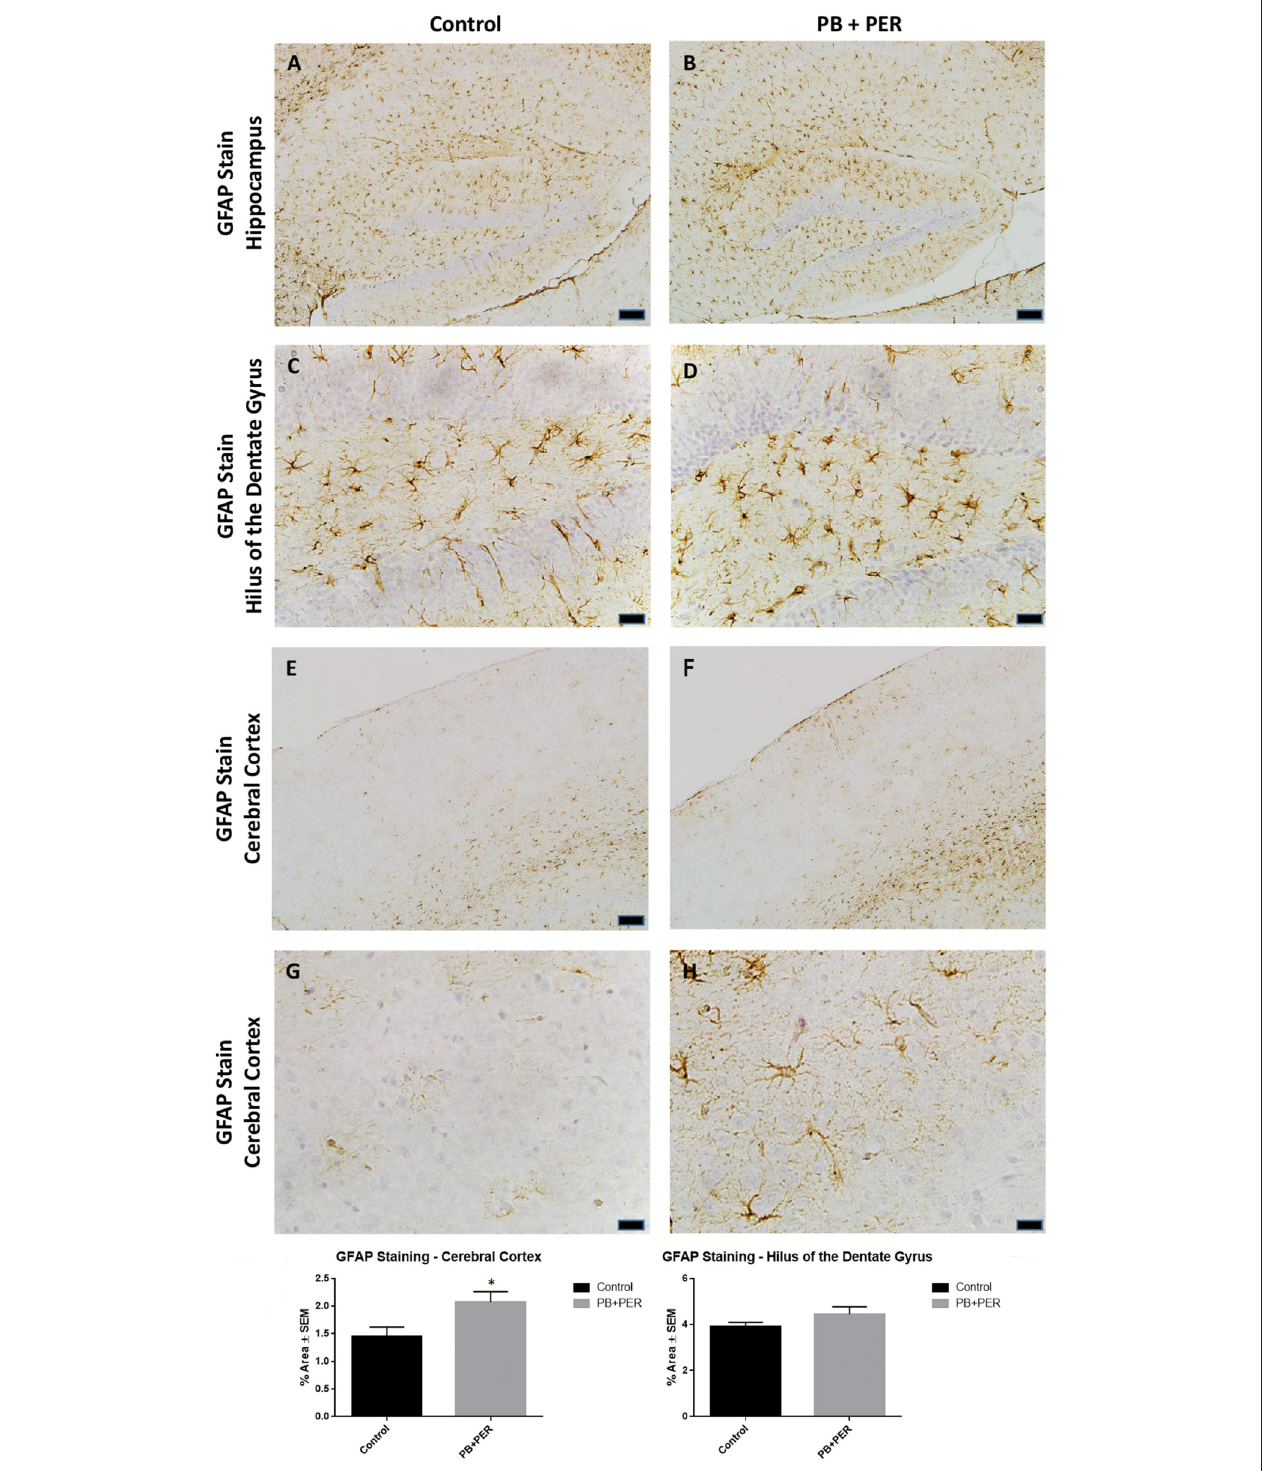
FIGURE 8 | PB + PER exposure altered astrocytic activation in the cerebral cortices of mice, 22.5 months post exposure. PB + PER exposure did not significantly alter astrocytic activation in the hippocampi of exposed mice (B,D) compared to controls (A,C) at 22.5 months post exposure. PB + PER exposure significantly increased astrocytic activation in the cerebral cortices (F,H) of exposed mice, as compared to controls (E,G) at 22.5 months post exposure. Representative images used 10X (A,B,E,F) , and 40X (C,D,G,H) objectives (scale bars represent 100 and 20 µ m, respectively). Histograms depict the quantification of the GFAP stain in the hippocampi and cerebral cortices from control and exposed mice, as % Area per microscopic field. * p < 0.05 .